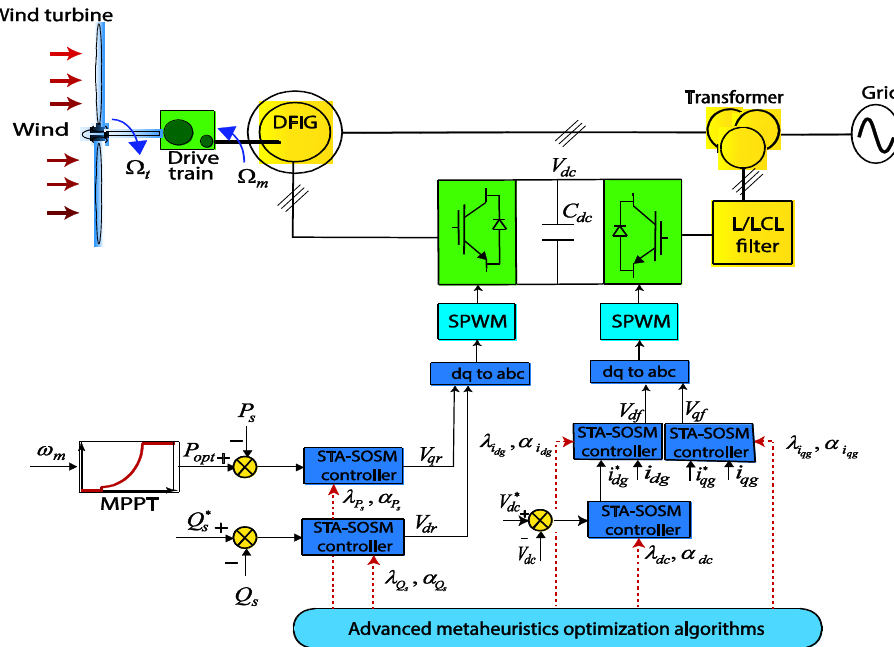
Figure 1. Metaheuristics-tuned direct power control block diagram of the doubly-fed induction generator (DFIG)-based Wind Energy Conversion System (WECS).